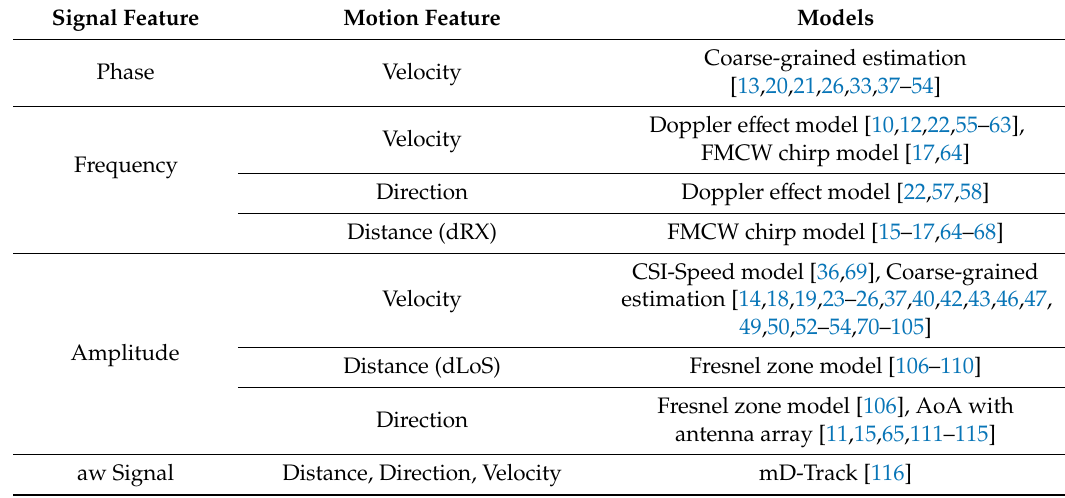
Table 4. Summary of models between human activities and parameters of wireless signal propagation